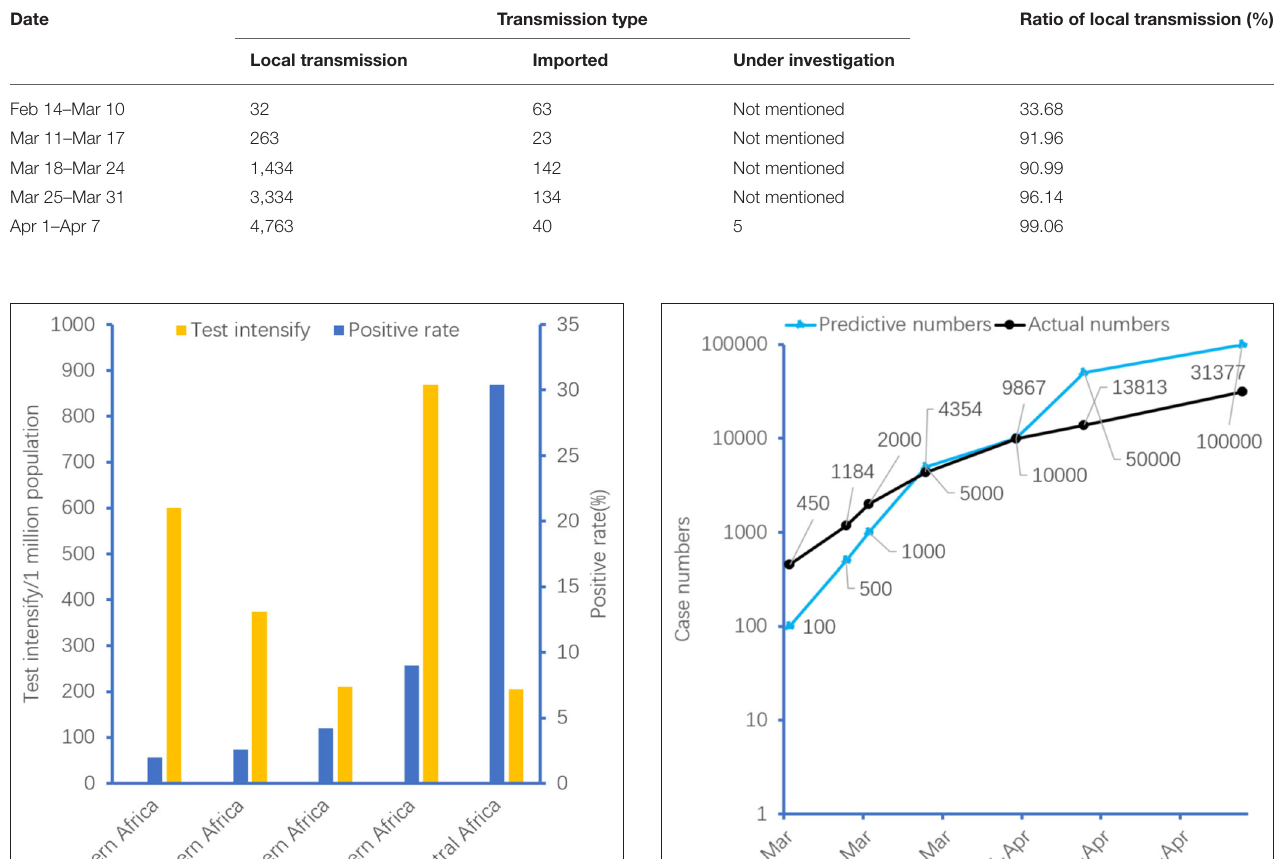
TABLE 2 | Transmission type of COVID-19 in Africa.